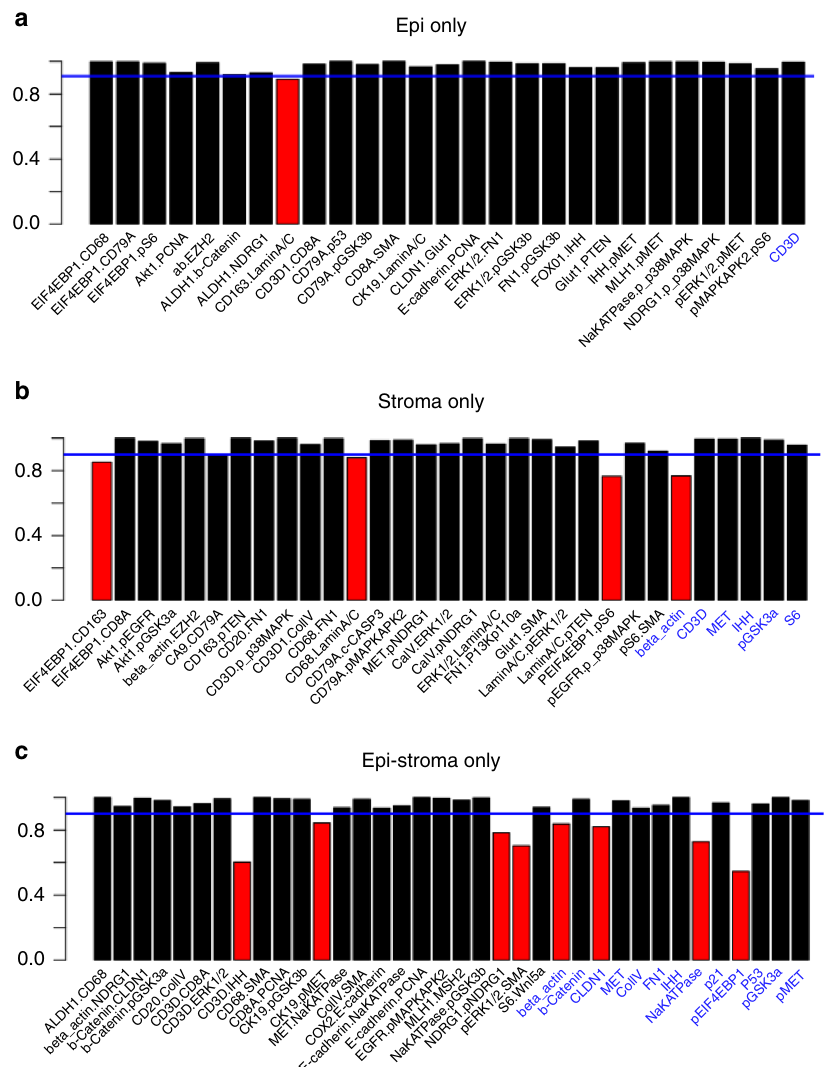
Fig. 3 SpAn stability analysis. a – c Stability analysis of the selected features for each of the spatial domains, with only those features from the ones selected in Fig. 2b that maintain their sign in 90% of the 500 bootstrap runs are included as input into the SpAn spatial model. These features are visualized in black in the three bar graphs. Features selected in Fig. 2b that did not meet this criterion are shown in red. The blue solid line indicates the 90%